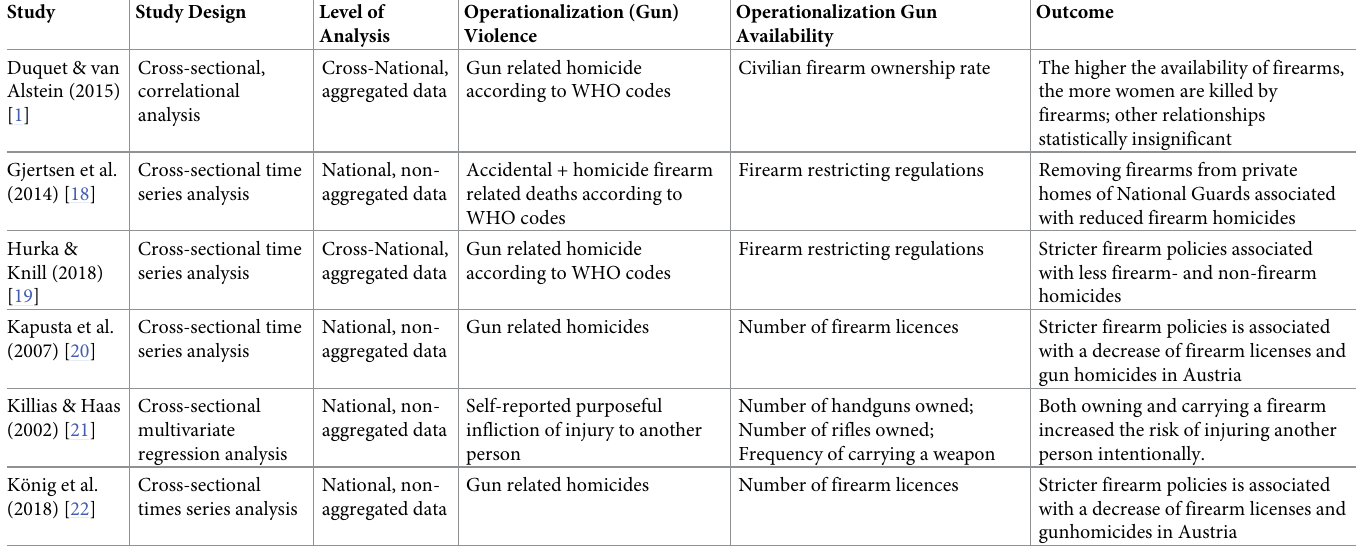
Table 2. Study design, level of analysis, operationalizations for gun violence and availability and outcome of included